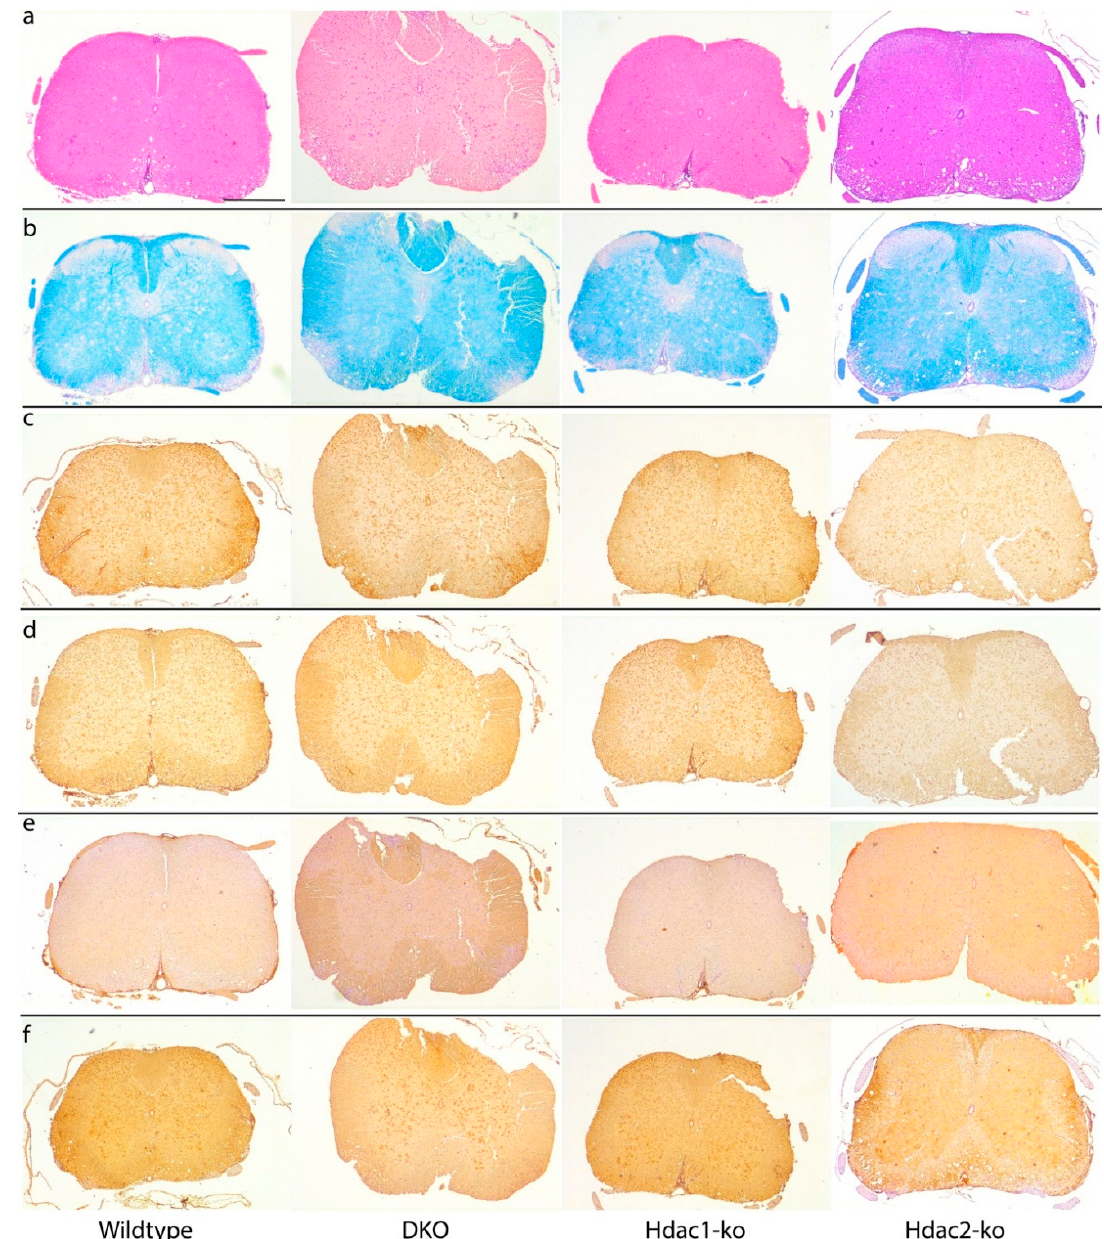
Figure 2. Representative histological and immunohistochemical stainings of ( a ) spinal cord lesions (H&E), ( b ) myelination (Luxol fast blue (LFB)), ( c ) microglia/macrophage infiltrates (Mac-3), ( d ) T-cell infiltrates (CD3), ( e ) B-cell infiltrates (B220) and ( f ) axonal damage (APP). Scale bar = 500 μ m; all images have the same scaling.